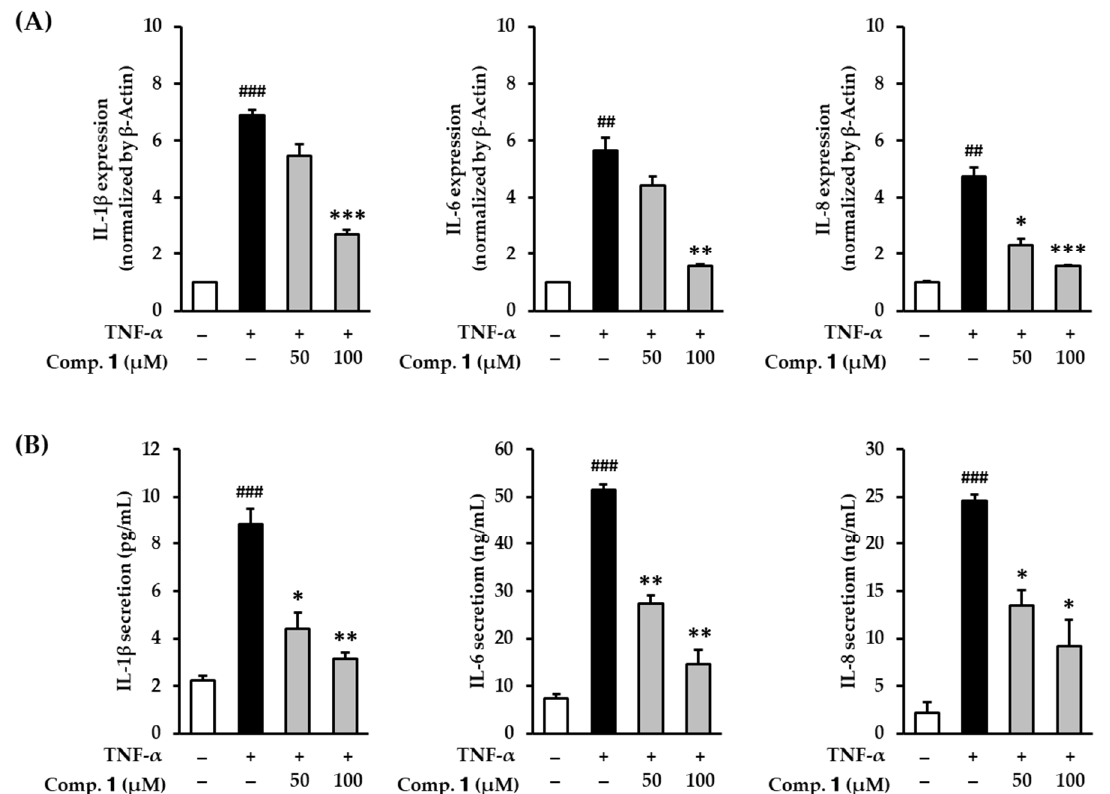
Figure 5. Effects of 1,3-dihydroxy-2,8-dimethoxy-6-methylanthraquinone ( 1 ) on mRNA and protein expression of proinflammatory cytokines IL-1 β , IL-6, and IL-8 in TNF- α -stimulated HDFs. HDFs were untreated or treated with TNF- α , followed by treatment with 1 for 4 h or 12 h. The mRNA and protein expression levels were determined using qRT-PCR and ELISA. ( A ) Relative mRNA expression levels of IL-1 β , IL-6 , and IL-8 . ( B ) Protein expression of IL-1 β , IL-6, and IL-8. The data are presented as mean ± SEM from three independent experiments. ## p < 0.01 and ### p < 0.001 difference compared to untreated cells. * p < 0.05, ** p < 0.01, *** p < 0.001 difference compared to TNF- α -stimulated cells.